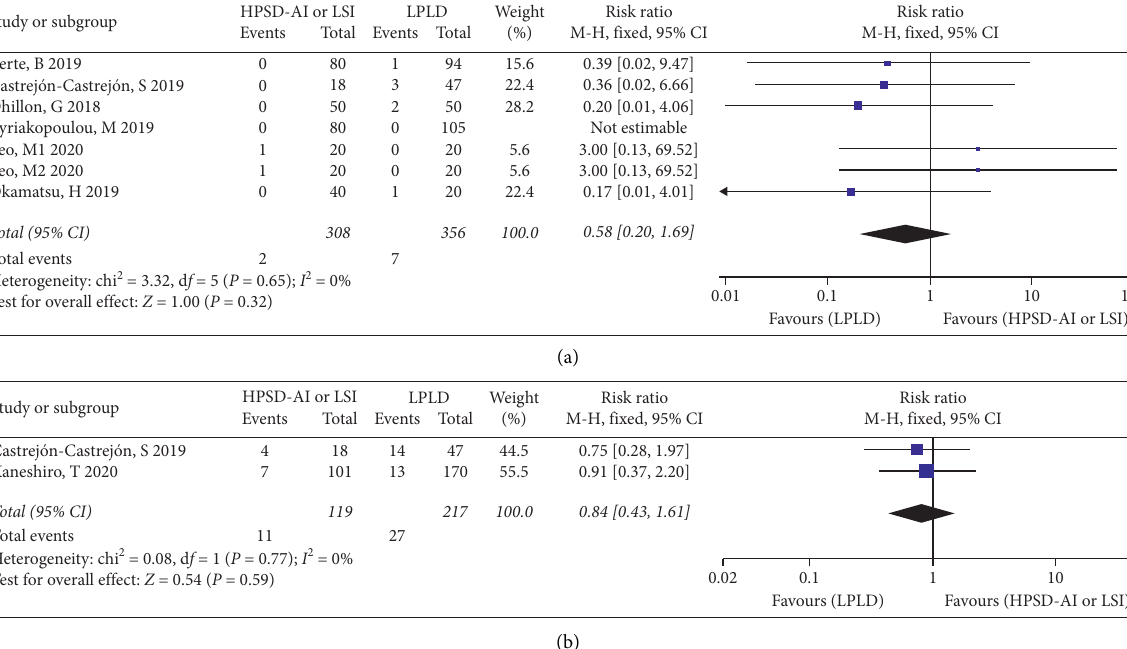
Figure 4: Forest plot displaying risk estimates of the primary safety outcome. (a) Complication rate and (b) esophageal lesion